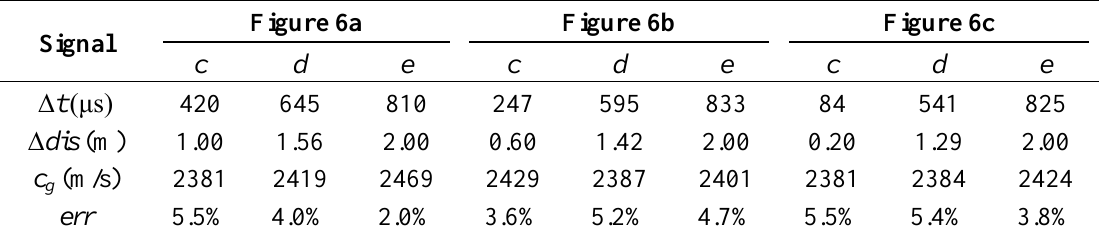
Table 1. Estimation of c of the ULW transmitted and received by the new CFC EMATs. g Figure 6a Figure 6b Figure Signal